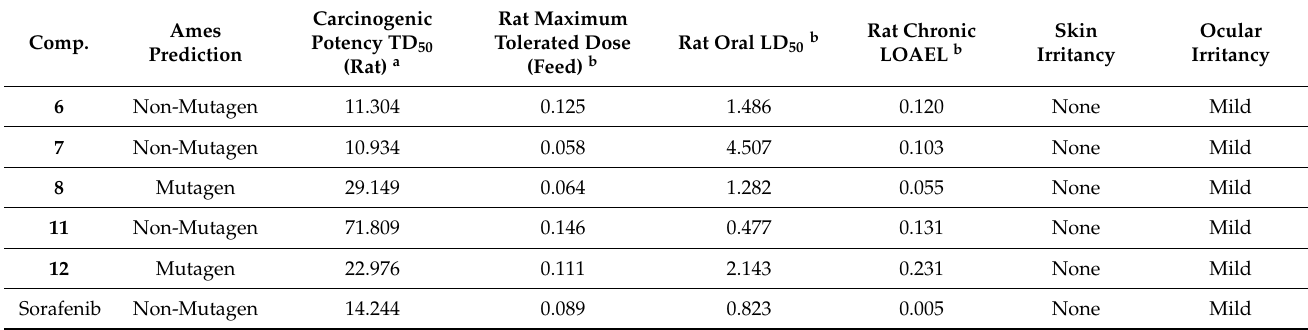
Table 10. In silico toxicity potential of the synthesized